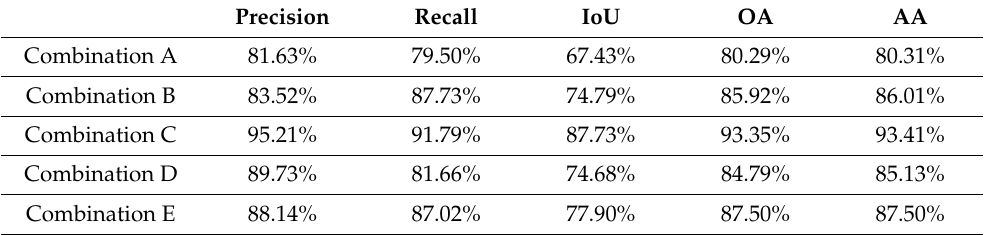
Table 8. Results of quantitative evaluation by different combination.